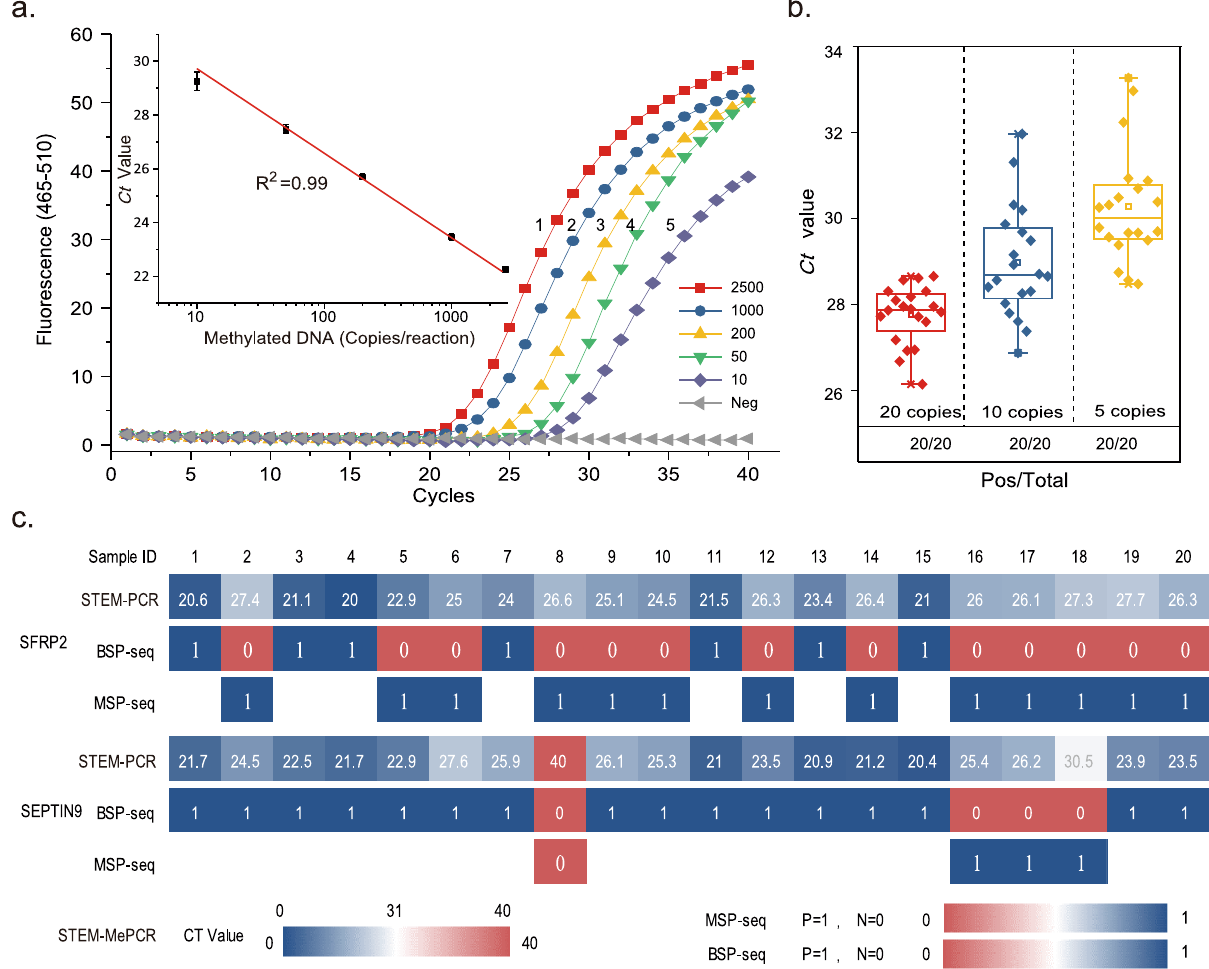
experiments of STEM-PCR with 5 (yellow), 10 (blue), and 20 copies/reaction (red) input methylated DNA using GlaI on SEPTIN9 genomic DNA — box plots display the average, boundaries are upper and lower quartiles respectively, whilst top and bottom bars are maximum and minimum (all points are shown); c Comparison of STEM-PCRandBSP-sequencingandMSP-sequencing 21 .Sourcedataareprovidedas a Source Data fi